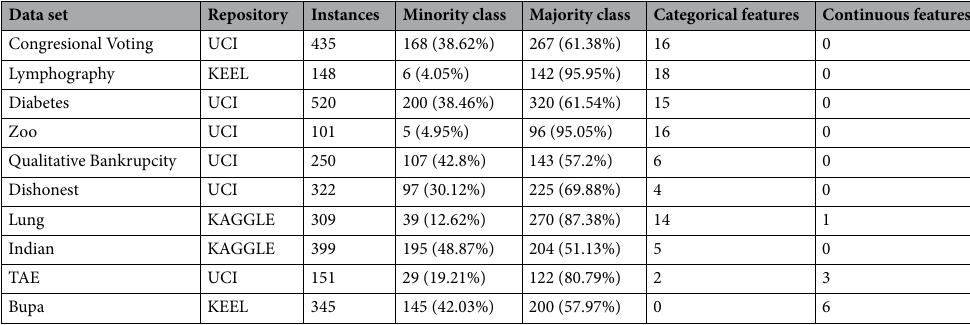
Table 2. Summary of data sets whose results are statistically insignificant to compare BOSME with